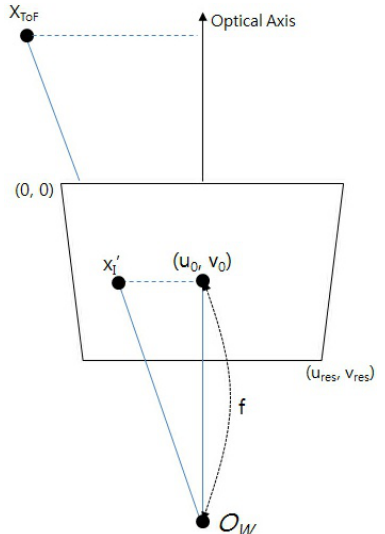
Figure 4. Structure of ToF camera: a 3D point ( X image plane of a ToF